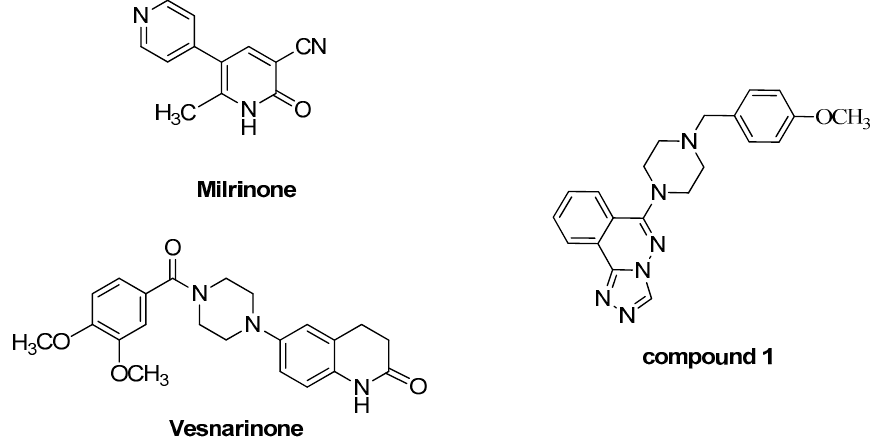
Figure 1. Cardiotonic agents used for the treatment of congestive heart failure (CHF) and the previously reported compound A .